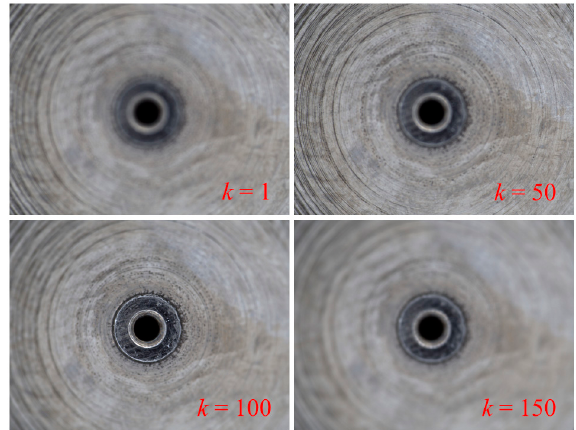
Figure 12. Sharpness variation of an image sequence.